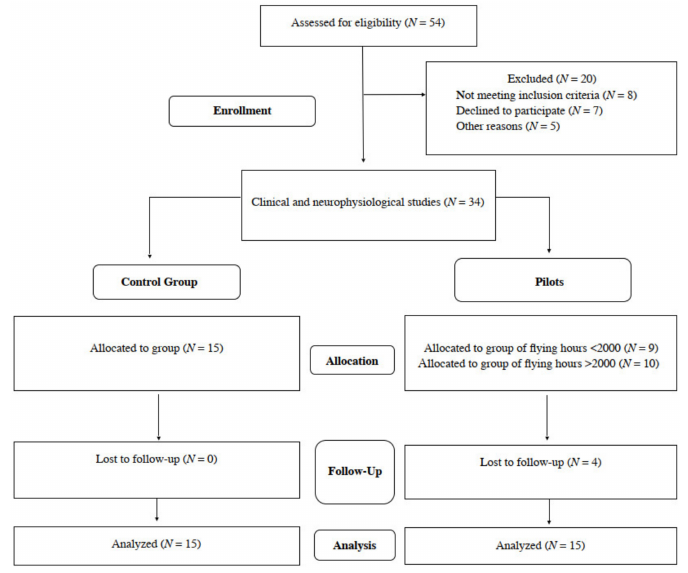
Figure 1. Flow chart of the